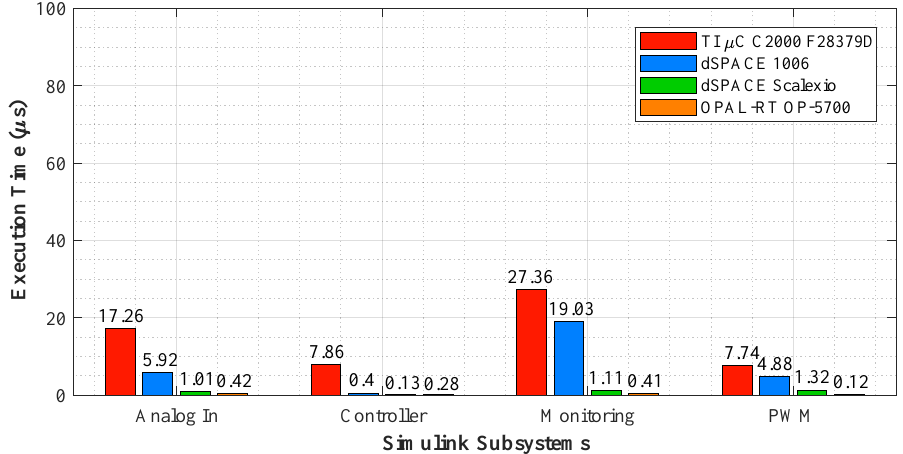
Figure 14. Computation time profiles for the PI ( dq ) controller of the full version.